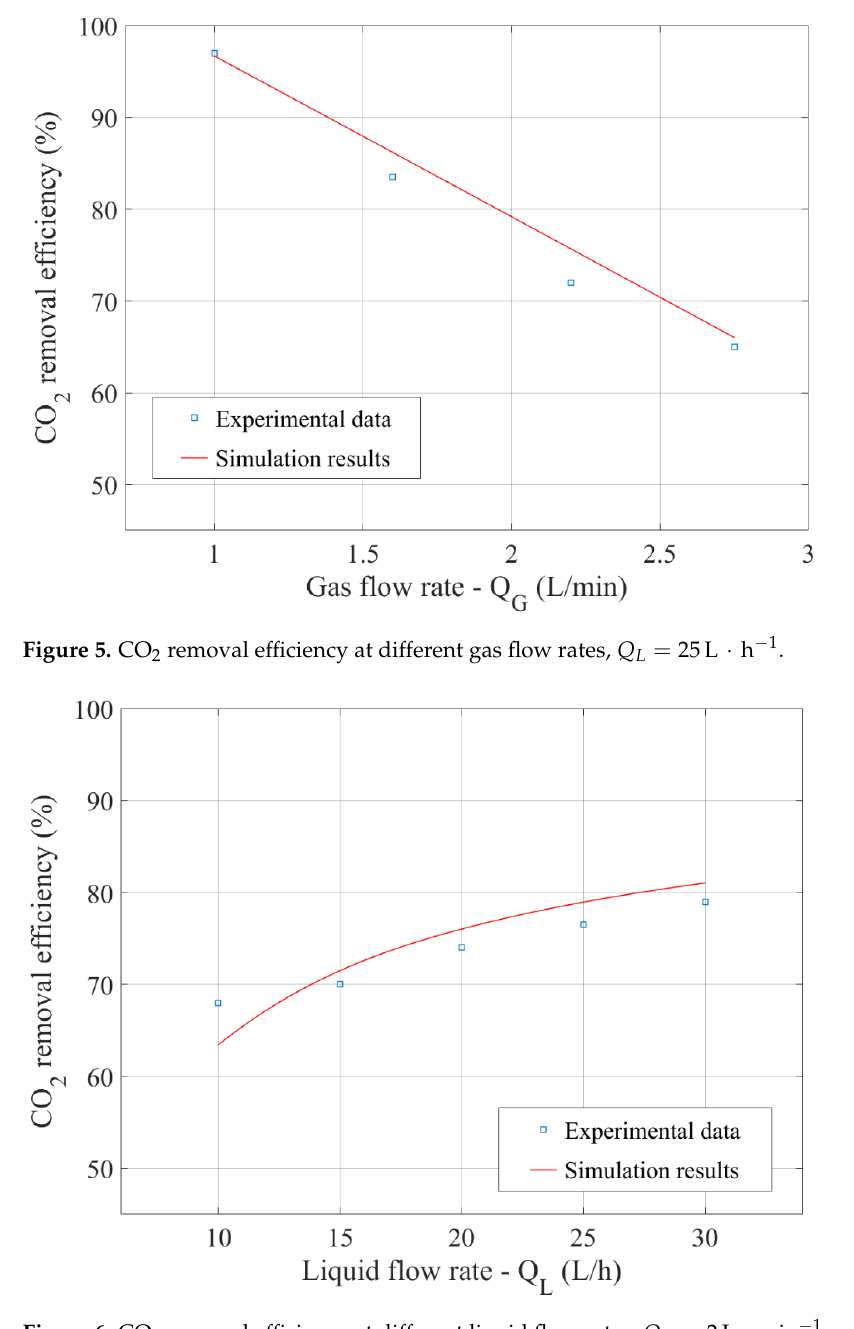
Figure 6. CO 2 removal efficiency at different liquid flow rates, Q G 1 2 min